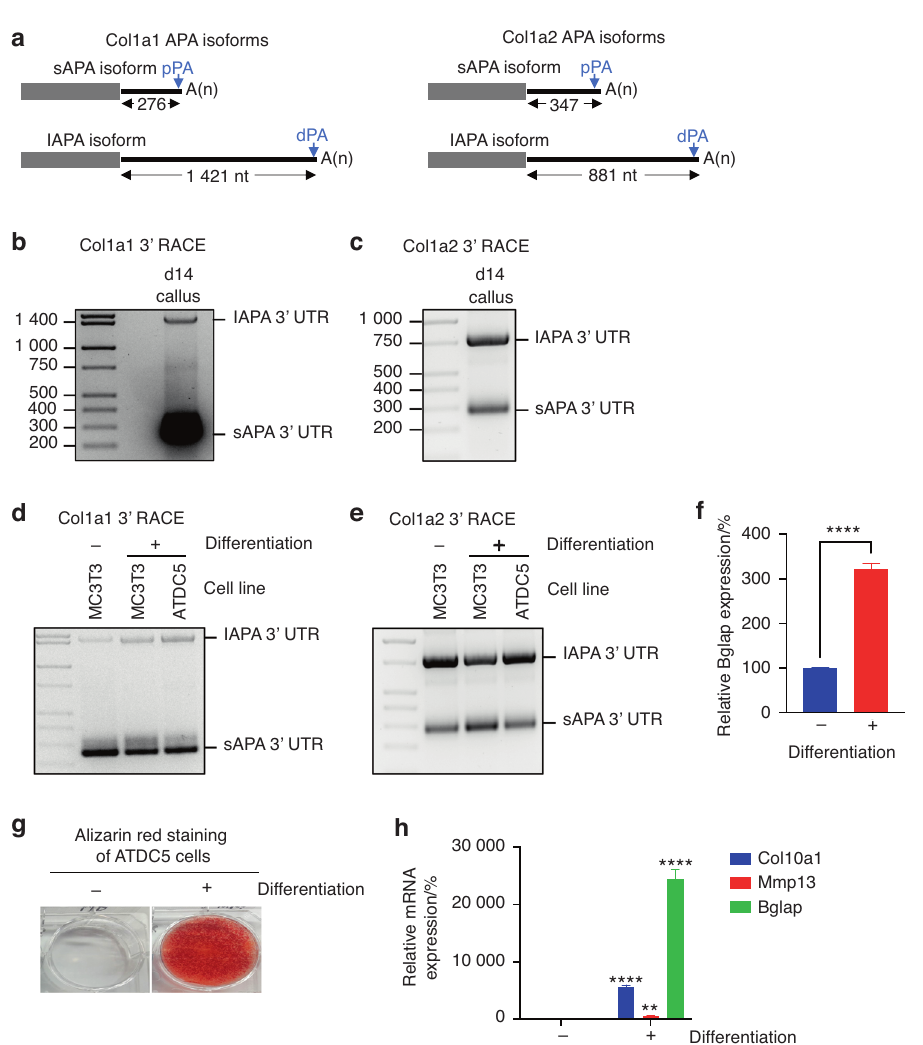
Fig. 3 Long and short APA isoforms of the Col1a1 and Col1a2 mRNAs are expressed in the fracture callus as well as osteogenic and chondrogenic cell lines. a Schematic of the lAPA and sAPA isoforms of Col1a1 (left) and Col1a2 (right). The determined size of the 3 ′ UTR of each isoform is shown. b Representative gel image of Col1a1 3 ′ RACE-PCR products showing the 2 APA isoforms. 3 ′ RACE was performed using RNA puri fi ed from d14 calli (3 ′ RACE procedure is shown in Fig. S8a, b). The 3 ′ end of each APA isoform was mapped by excising and sequencing the corresponding PCR band (Fig. S9a). c As in b , except 3 ′ RACE-PCR was performed on Col1a2 mRNA. Sequencing of the PCR products con fi rmed the lAPA and sAPA isoforms that were identi fi ed by InPAS (Fig. S9b). d , e As in b and c , respectively, except that RNA was puri fi ed from the indicated cell lines. ATDC5 cells were differentiated under conditions that promoted hypertrophic differentiation and mineralization (Fig. S10). f RT ‒ qPCR analysis of the expression of the osteoblast and mineralization marker bone gamma carboxyglutamate protein (Bglap) in undifferentiated and differentiated MC3T3 cells. The mRNA expression level of Bglap was normalized to that of β -actin, and the normalized level in undifferentiated cells was de fi ned as 100. g Alizarin red staining of ATDC5 cells before ( − ) and after ( + ) 3 weeks of differentiation. Positive staining of differentiated cells indicated chondrocyte mineralization (Fig. S10). h As in f except that RNA was puri fi ed from ATDC5 cells shown in g , and the speci fi ed transcript levels were quanti fi ed. The results demonstrate high expression of chondrocyte hypertrophy and mineralization markers in the differentiated ATDC5 cells. Gel images are representative of three independent replicates. The bar graphs present the average of three independent replicates ± SEM. ** P < 0.01; **** P < 0.000 1 using unpaired Student ’ s t